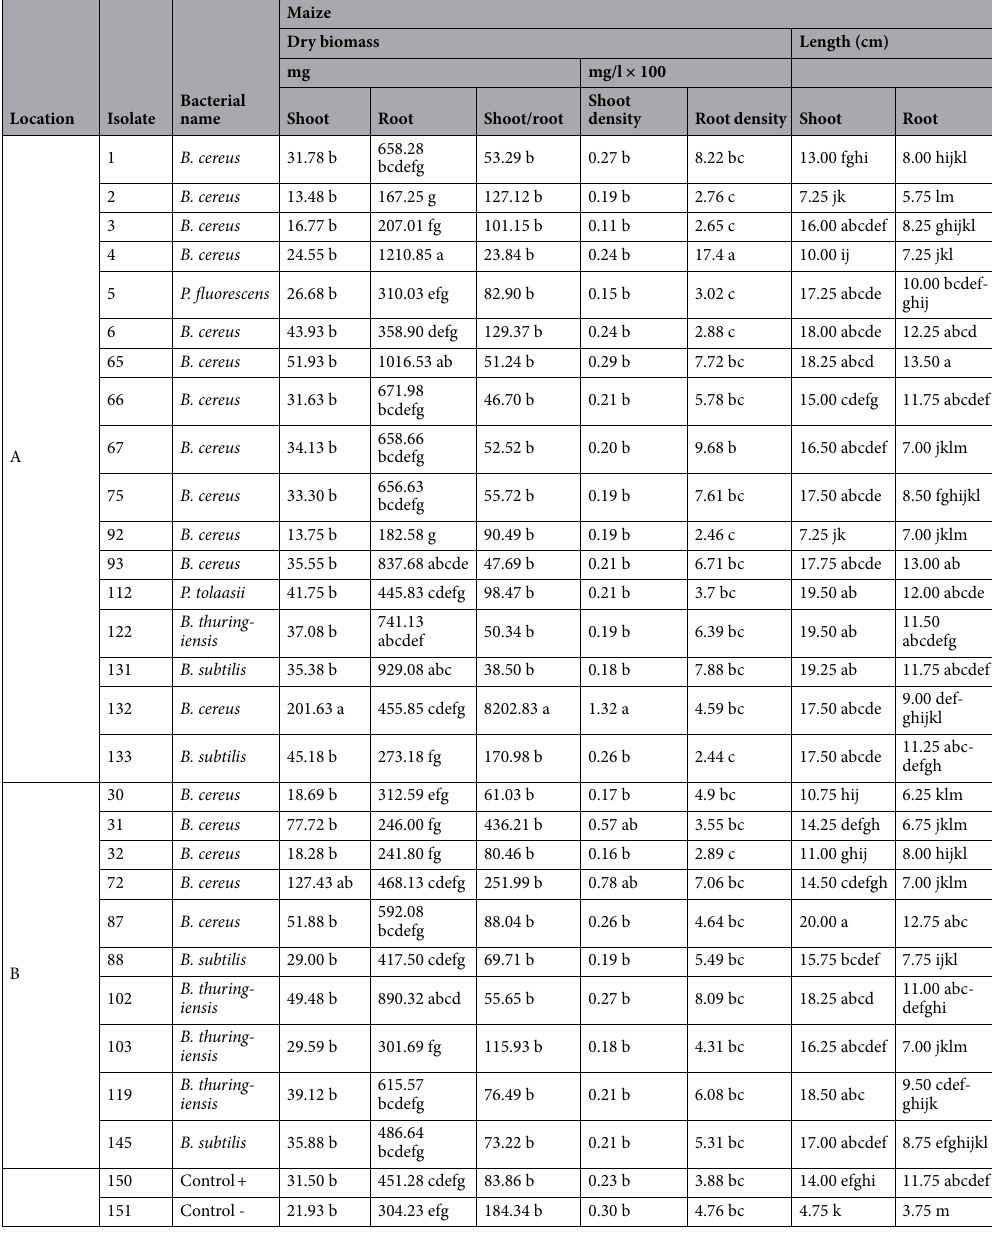
Table 6. Influence of soil isolates on growth parameters after 21 days of assessment on maize. LSD p = 0.01 value for the parameters on maize, respectively: 0.1151398, 0.5349834, 4.409074, 0.007713552, 0.06318265, 4.12234, 3.276811; A and B were indicated sampling